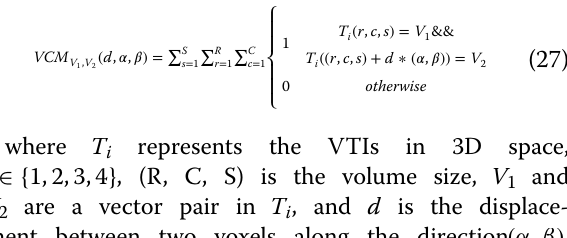
The magnitude, azimuth angle and polar angle com- pose the total Hessian vector (THV) given by: